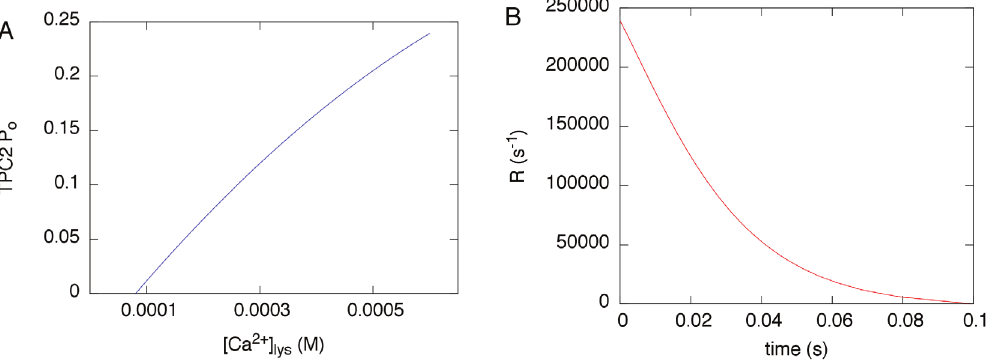
Figure 6. A , open probability P of the TPC2-dependent Ca 2+ conductance reproduced from a quadratic fit to the data reported in the o literature 45 . B , Ca 2+ release rate calculated as explained in the text, based on the P